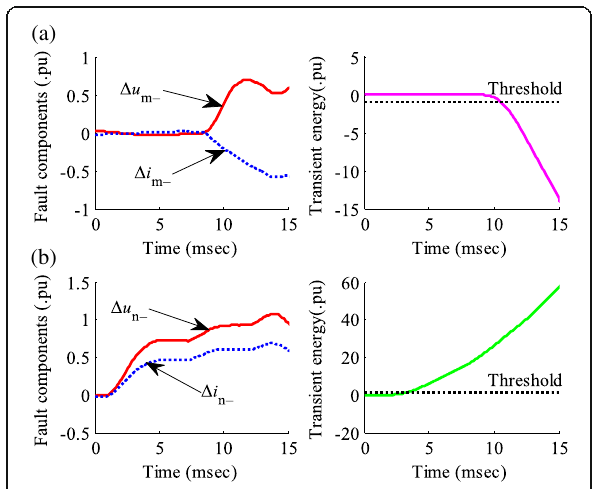
Fig. 14 Waveforms of fault components and transient energies detected on the negative pole line for a fault at F 5. a Rectifier station. b Inverter